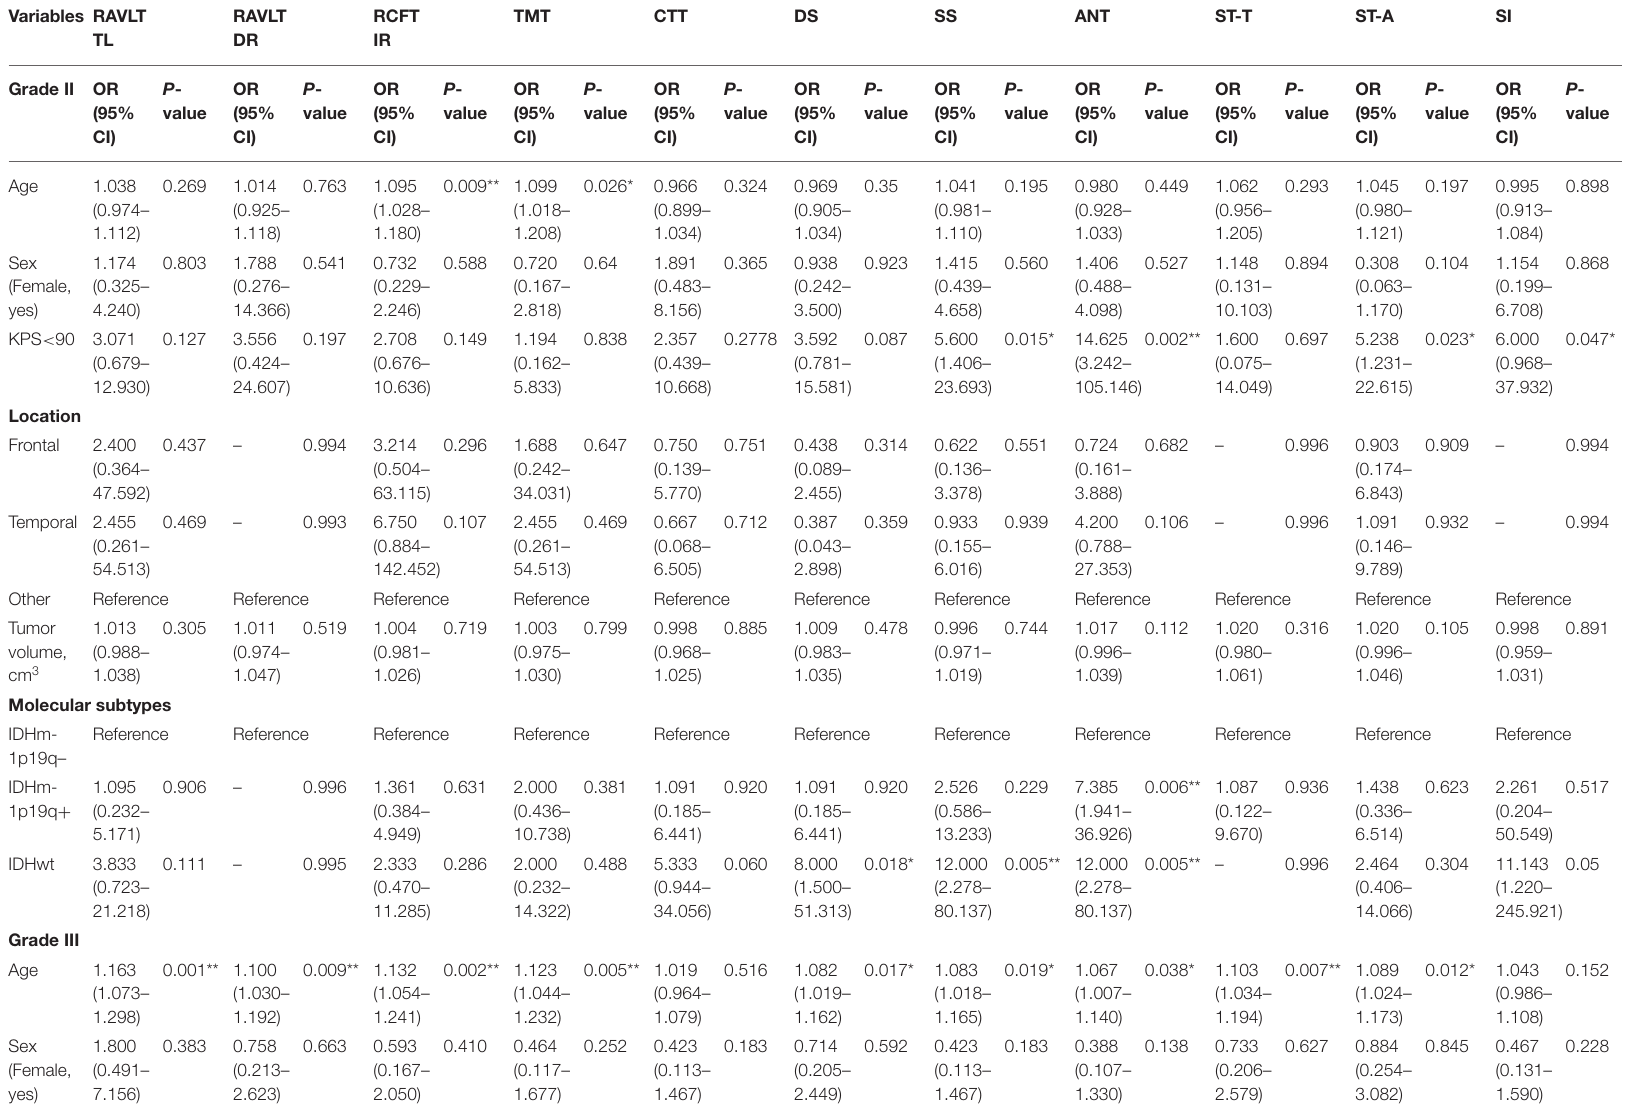
TABLE 8 | Univariate analysis of clinical and molecular variables for lower-grade glioma patients. Variables RAVLT